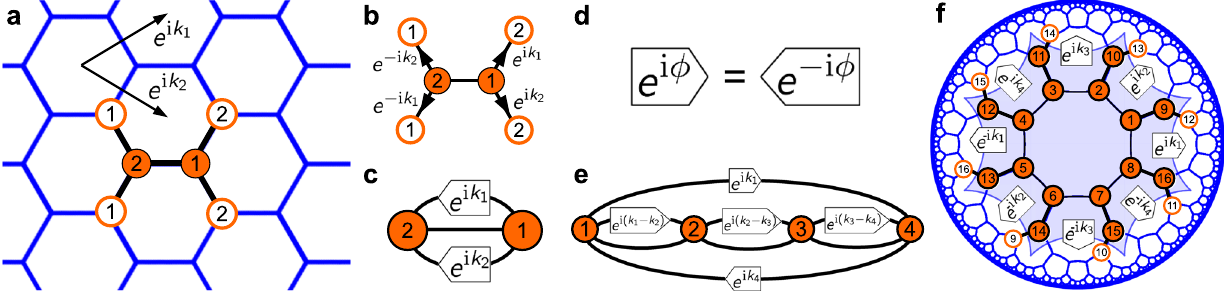
Fig. 1 | Unit-cell circuits. a Euclidean {6, 3} honeycomb lattice with twosites in the unit cell (full orange circles). Each site has 3 neighbors, some of them in adjacent unitcells(emptyorangecircles). b Thewavefunctionofparticleshoppingbetween unit cells picks up a complex Bloch phase, see Eq. (1). c The associated unit-cell circuit diagram encodes the Bloch-wave Hamiltonian H ( k ), Eq. (2), and the energy bands.Momentum k =( k 1 , k 2 )isanexternalparameter. d Intopolectricalcircuits,a